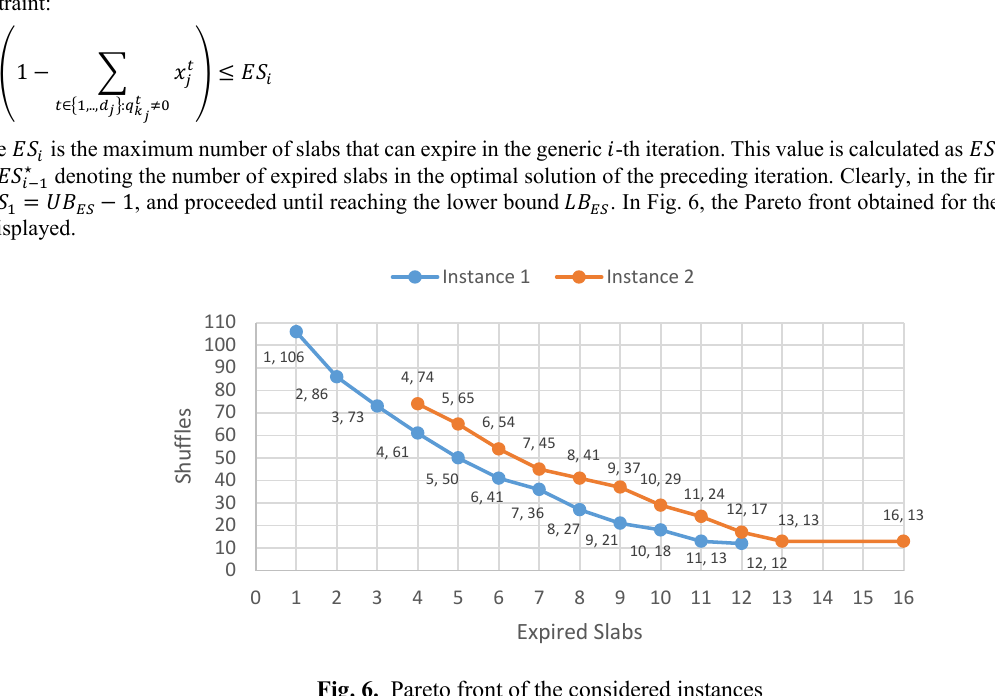
Fig. 6. Pareto front of the considered